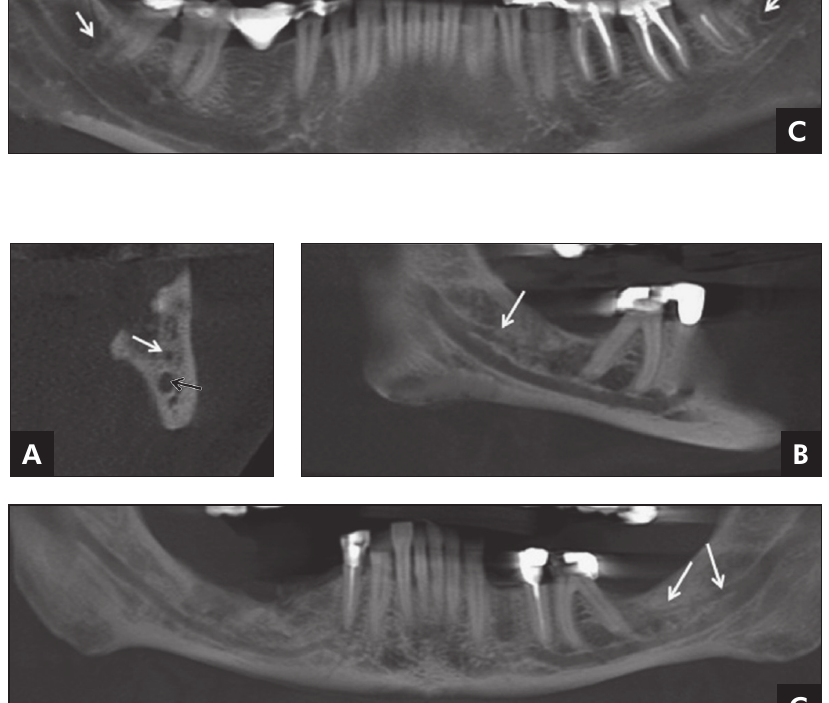
Figure 2 - Bilateral bifurcation extending to the region of the third molar and adjacencies (Type 1B). Right ( A ) and left ( B ) lateral and panoramic ( C ) views. The white arrows indicate the mandibular canal bifurcation.